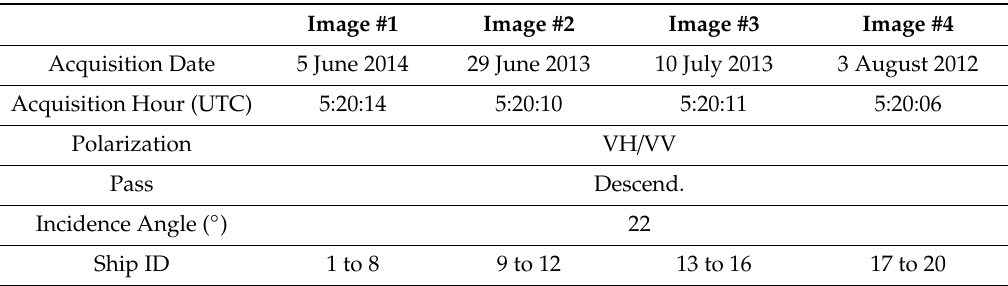
Table 1. SAR Data Set (StripMap